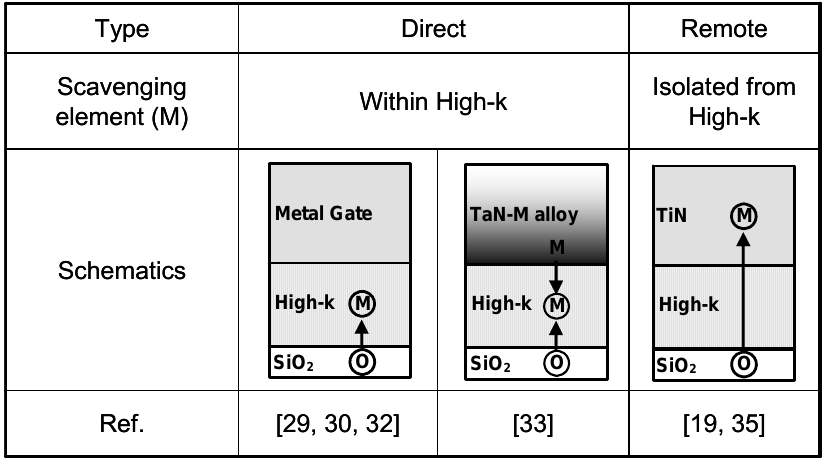
Figure 3. Schematics of direct- and remote- scavenging techniques in the literature.